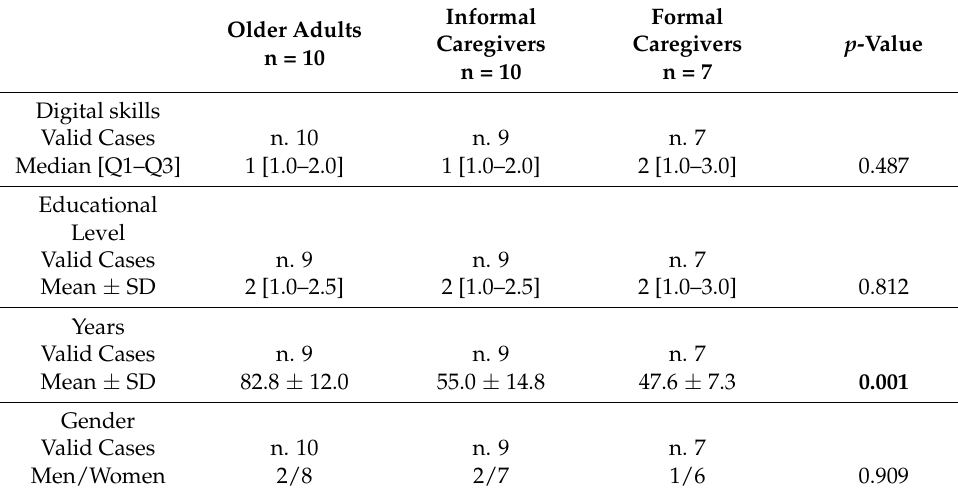
Table 6. A brief overview of the population recruited in Phase 1.